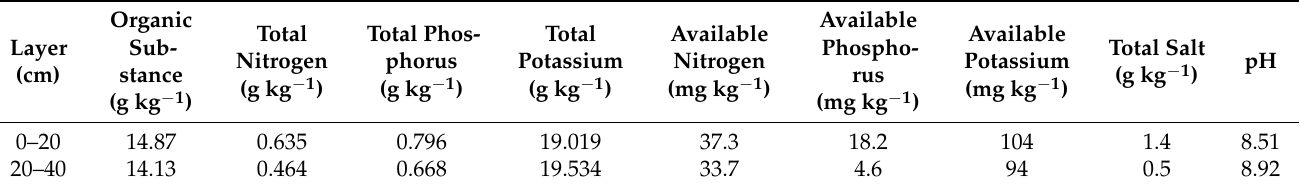
Table 1. Soil conditions of the trial